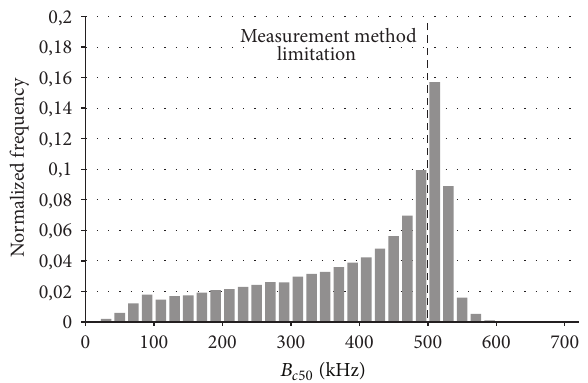
Figure 17: Histogram of coherence bandwidth values estimated from Fourier transform of PDP for correlation level 0.9 in hilly terrain.